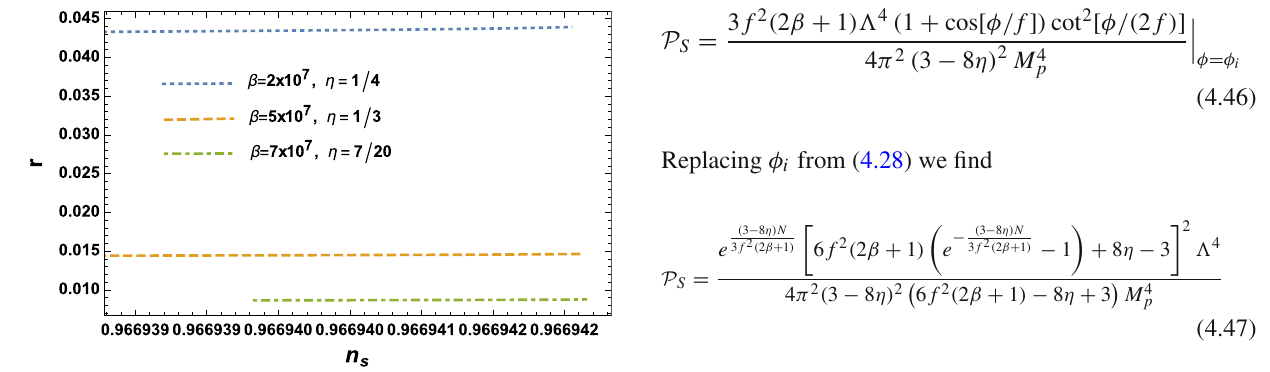
Fig. 5 n s vs r for f in the interval 0 . 01 ≤ f ≤ 0 . 001 and N = 60. In all curves n s ≈ 0 . 967 while r is also constant along the studied interval for each curve, but it varies from one curve to another depending on β and η